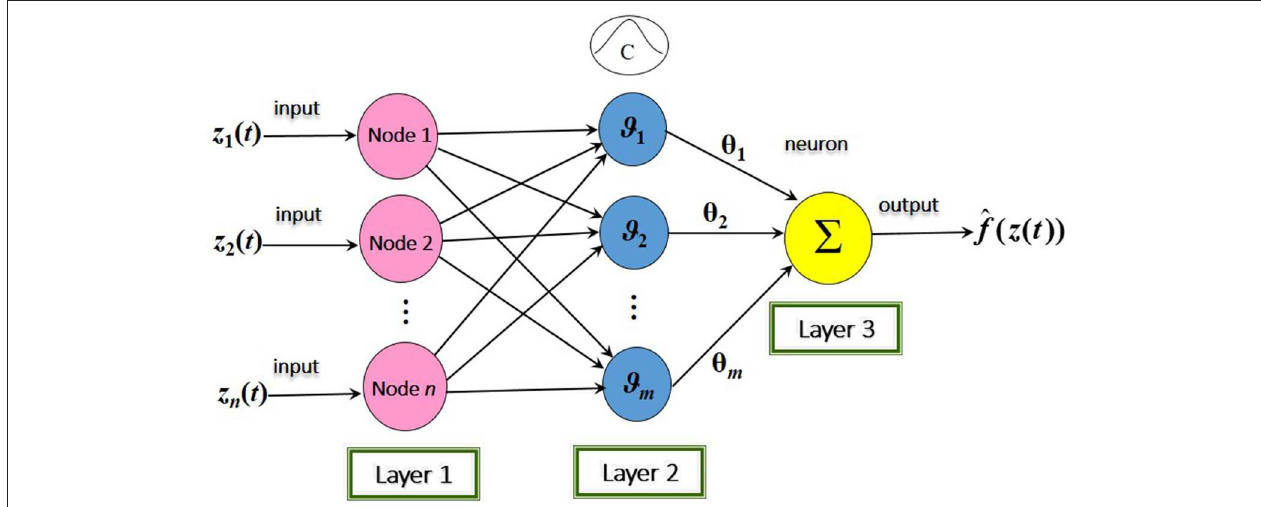
FIGURE 1 | The structure of